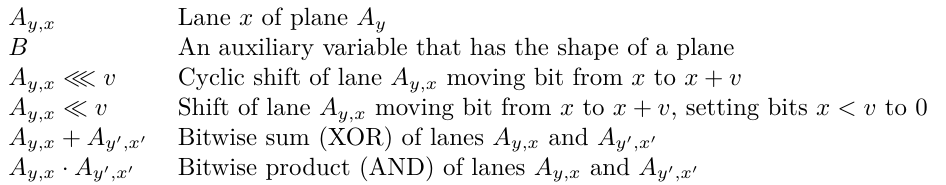
Table 3: Notational conventions for specification of the rolling functions A y,x Lane x of plane A y